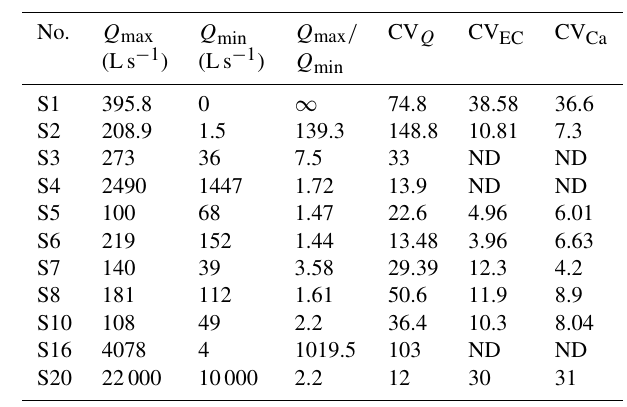
Table 4. Discharge characteristics of springs and variations in physico-chemical data.